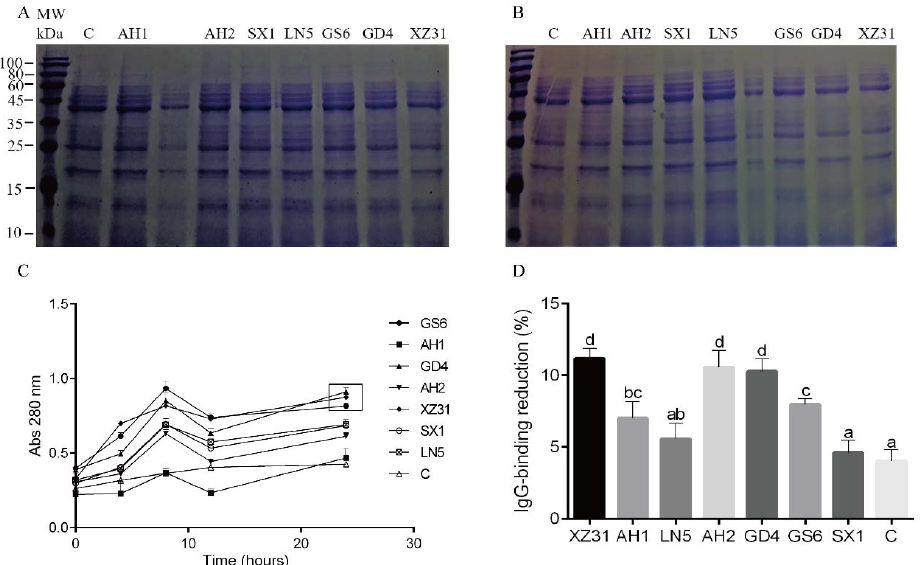
Figure 3. Sodium dodecyl sulfate ‐ polyacrylamide gel electrophoresis (SDS ‐ PAGE) of wheat protein extracts treated with lactic acid bacteria for 0 h ( A ) and 24 h ( B ). ( C ) The same samples in (A, B) were used to quantify the degree of hydrolysis at 280 nm. Each value represents the mean of three independent experiments. ( D ) IgG ‐ binding of wheat protein extracts treated with lactic acid bacteria. Bars that do not share a common lowercase letter differ significantly ( p < 0.05) ( n = 3). Control was the mixture without cellular suspension and incubated under the same conditions.